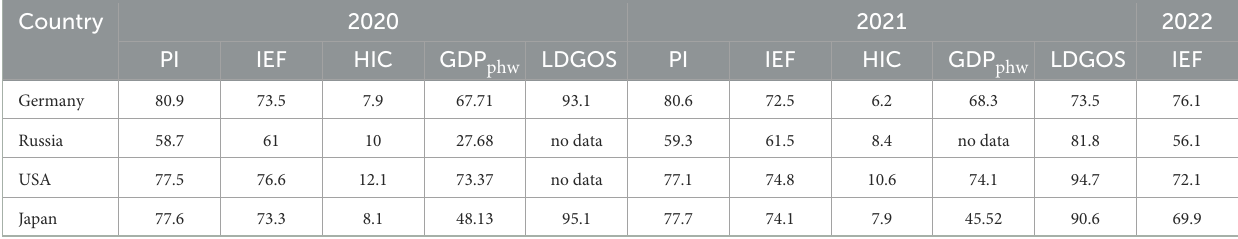
TABLE 1 Key indicators of human capital development in the context of digitalization of several national economies.